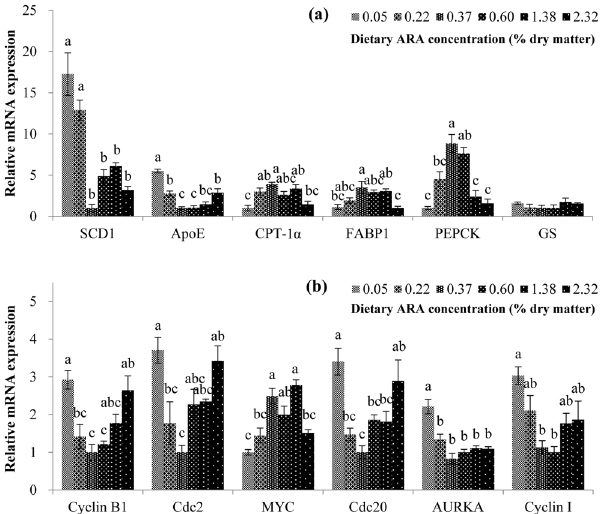
Figure 2. Validation of the transcriptome results by qRT-PCR measurement. ( a ) Lipid metabolism-related genes. ( b ) Cell cycle-related genes. The mRNA levels were expressed relative to β -actin. Results are expressed as means ± standard error (n = 3). Different letters above the bars denote significant ( P < 0.05) differences among dietary groups.